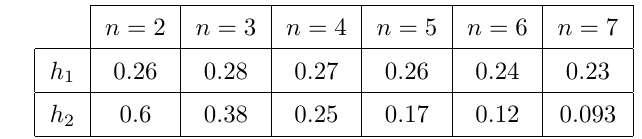
Table 2. Numerical values of h 1 and h 2 .